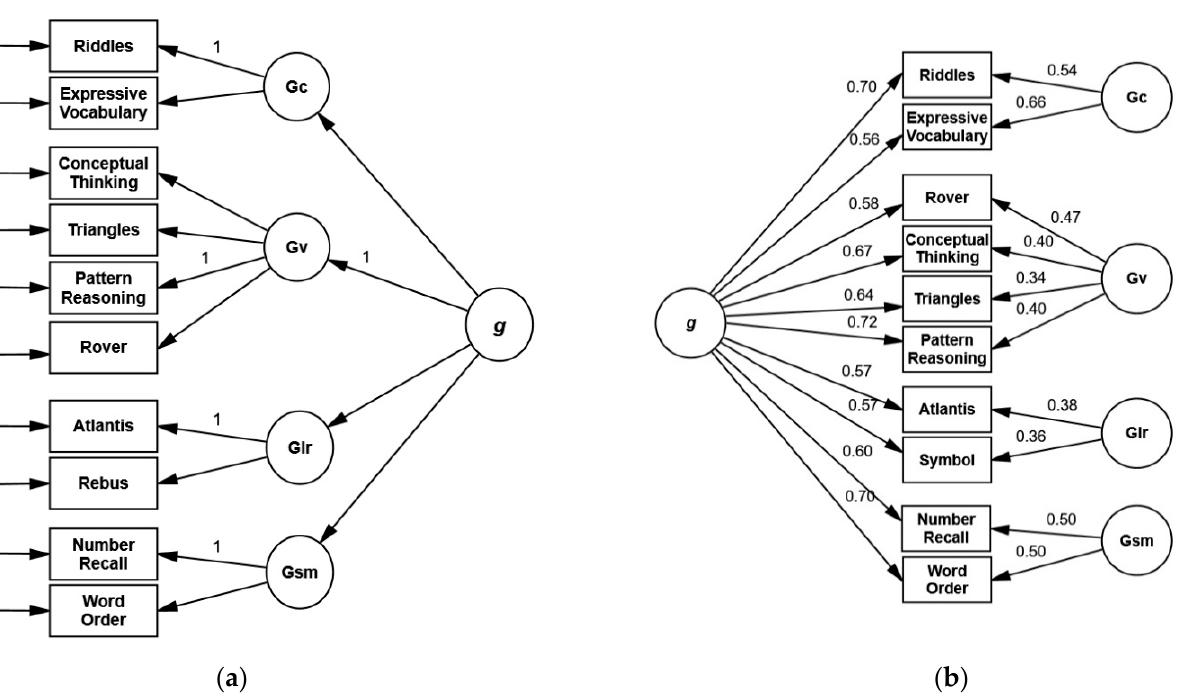
Figure 3. Second-order model 2b ( a ) and bifactor model 3b ( b ) with standardized loading coefficients for the KABC-II CHC subtest configuration at age 6. ( a ) χ 2 = 34.26, df = 31, p = 0.314, CFI = 0.996, RMSEA = 0.023, SRMR = 0.032. ( b ) χ 2 = 33.55, df = 31, p = 0.345, CFI = 0.997, RMSEA = 0.020, SRMR = 0.030.